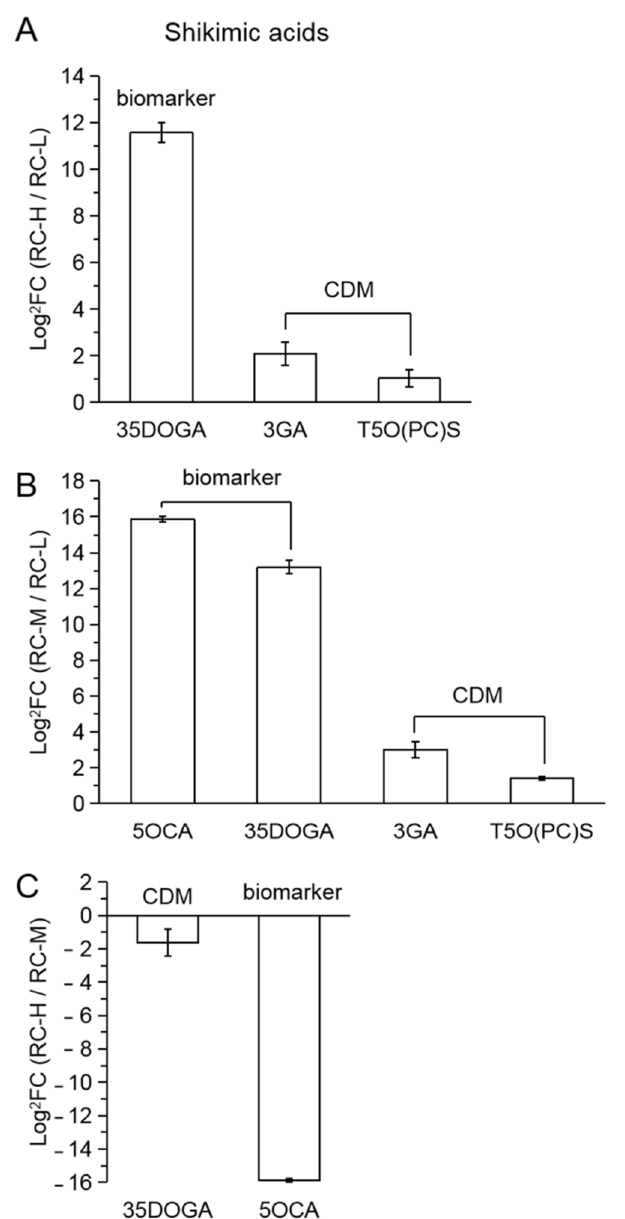
Figure 15. Comparison of differential metabolites of shikimic acids between RC-L, RC-M and RC-H. These were 1 biomarker and 2 CDMs for RC-H vs. RC-L ( A ), 2 biomarkers and 2 CDMs for RC-M vs. RC-L ( B ), and 1 biomarker and 1 CDM for RC-H vs. RC-M ( C ). Upregulation denotes that the content of a metabolite in RC increased with elevation between two altitudes, and the opposite for downregulation. The Y-axis is shown as Log 2 FC values for the convenience of visual presentation (Note: The up-amplitude in the text refers to the FC value). The X-axis denotes metabolite names. Shikimic acid-phenylalanine is an upstream metabolic pathway of phenylpro-